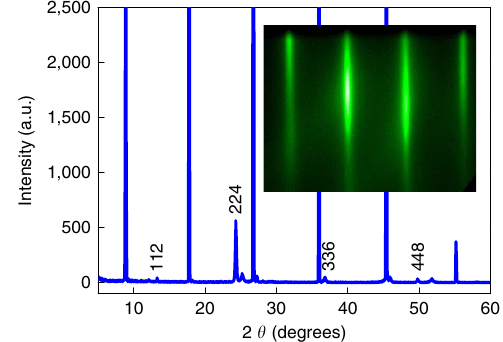
Figure 1 | Characterizations of Cd 3 As 2 thin film. X-ray diffraction pattern for Cd 3 As 2 thin film sample. The marked peaks correspond to {112} crystal plane of Cd 3 As 2 , while the other peaks come from the mica substrate. The inset is an in situ RHEED